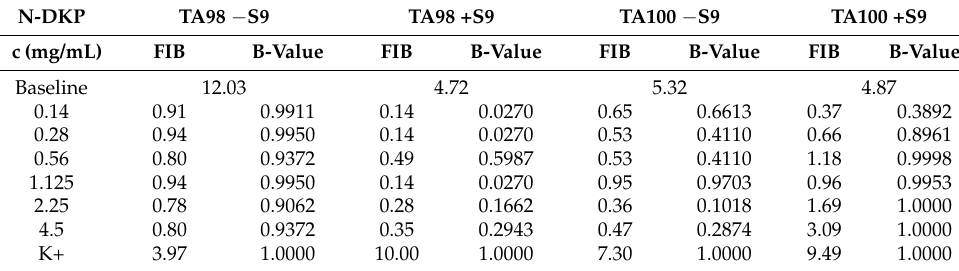
Table 6. The results of bacterial reverse mutation test for DKP nitrosation mixture (N-DKP). N-DKP TA98 − S9 TA98 +S9 TA100 − S9 TA100 +S9 c (mg/mL) FIB B-Value FIB